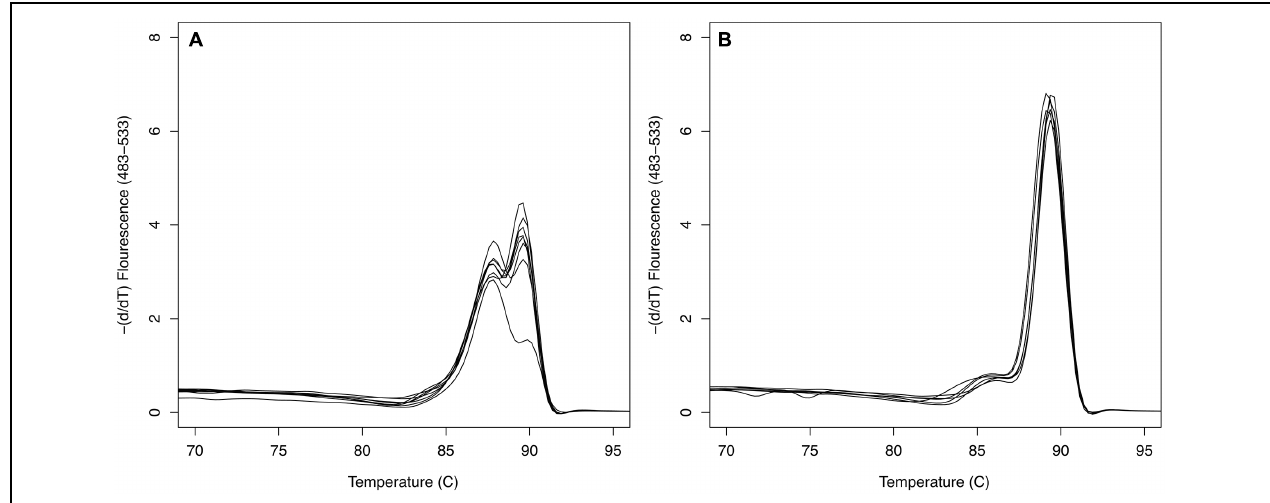
FIGURE 1 | SxtA4 qPCR melt curve comparison. (A) Bimodal melting curve of Alexandrium minutum strains VGO650, VGO651, RCC3227, and RCC3337 isolated from Brittany, France, producing PST isoforms C1/2, GTX2/3, and dcGTX2/3. (B) Single peak melting curves of strains AL1V, VGO577, AL10C, and Min3 producing PST isoforms GTX1/4 and GTX2/3.